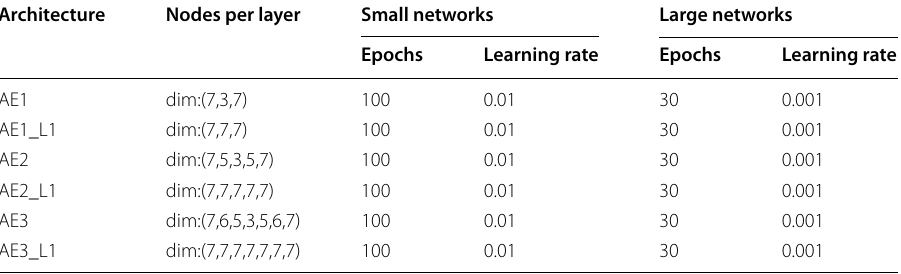
Table 3 Details of autoencoder architectures. Here AE* indicates the number of layers in compression autoencoders, and AE*_L1 indicates the number of layers in L1-constrained